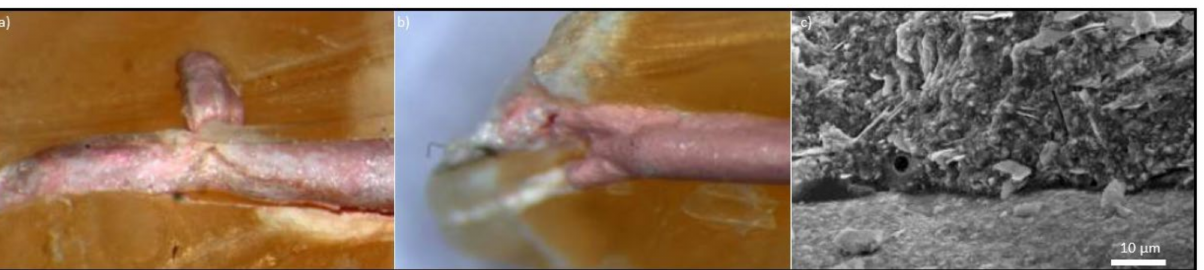
Figure 23. Filling with resilon as a filling material by thermoplastic condensation using the THC technique of the root canal and spaces constituting a branch of the central canal (SEM): ( a ) the lateral canal in the apical part filled with resilon covered with a sealant; ( b ) root canal delta filled with resilon centrally and centrifugally with sealant; ( c ) tight closure of the dentin canal orifices of the root canal wall with a fine and coarse-particle sealant with a visible mouth of the dentin canal of the root canal wall in the form of an oval